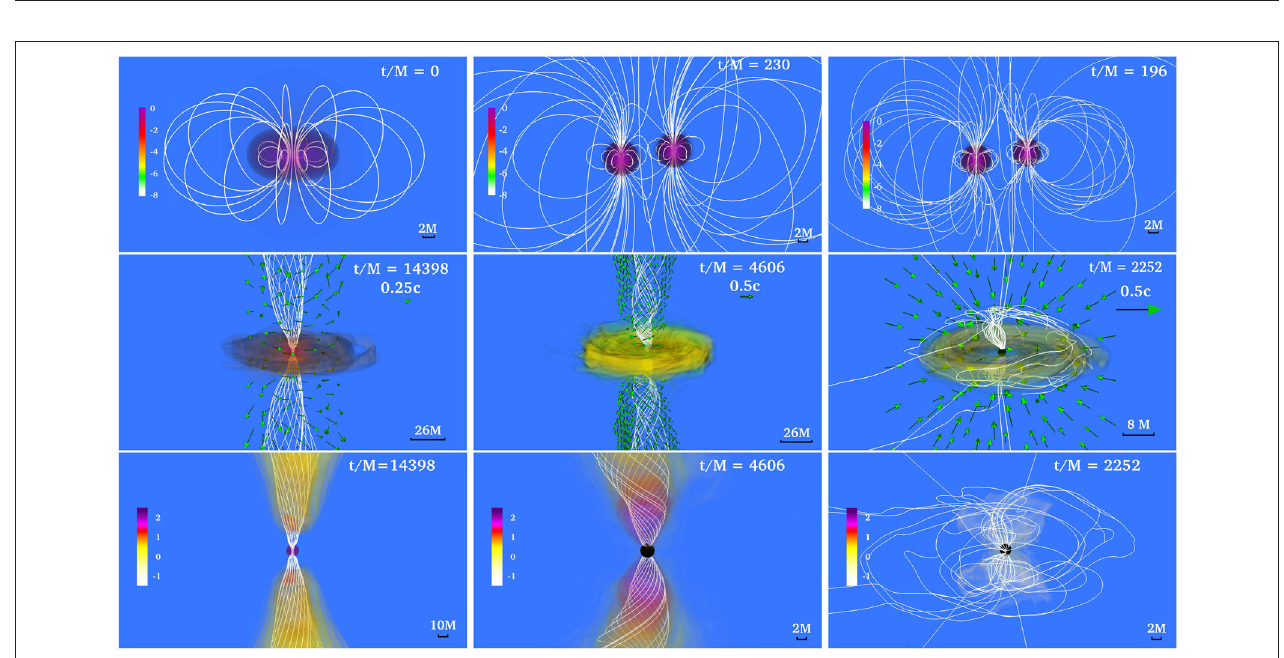
FIGURE 8 | NS rest-mass density ρ 0 normalized to its initial maximum value ρ 0,max = 5.9 × 10 14 (1.625 M ⊙ / M NS ) 2 g/cm 3 (log scale) at selected times for an NSNS merger. Arrows display plasma velocities and white lines show magnetic field lines. Here M = 1.47 × 10 − 2 ( M NS / 1.625 M ⊙ )ms = 4.43( M NS / 1.625 M ⊙ )km (Snapshots from case IH in Ruiz et al., 2016).